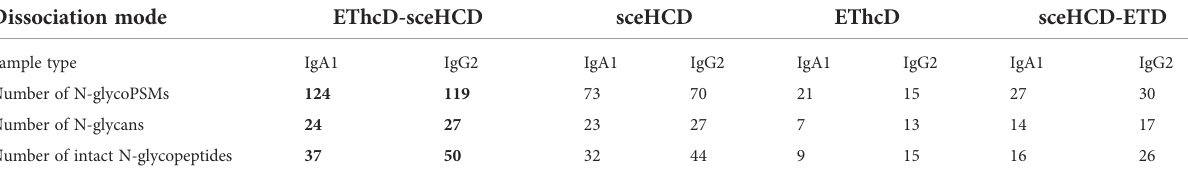
TABLE 2 Comparison of the N-glycosylation modi fi cations of human serum monoclonal IgA1 and IgG2 from patients with multiple myeloma using four different dissociation methods. Dissociation